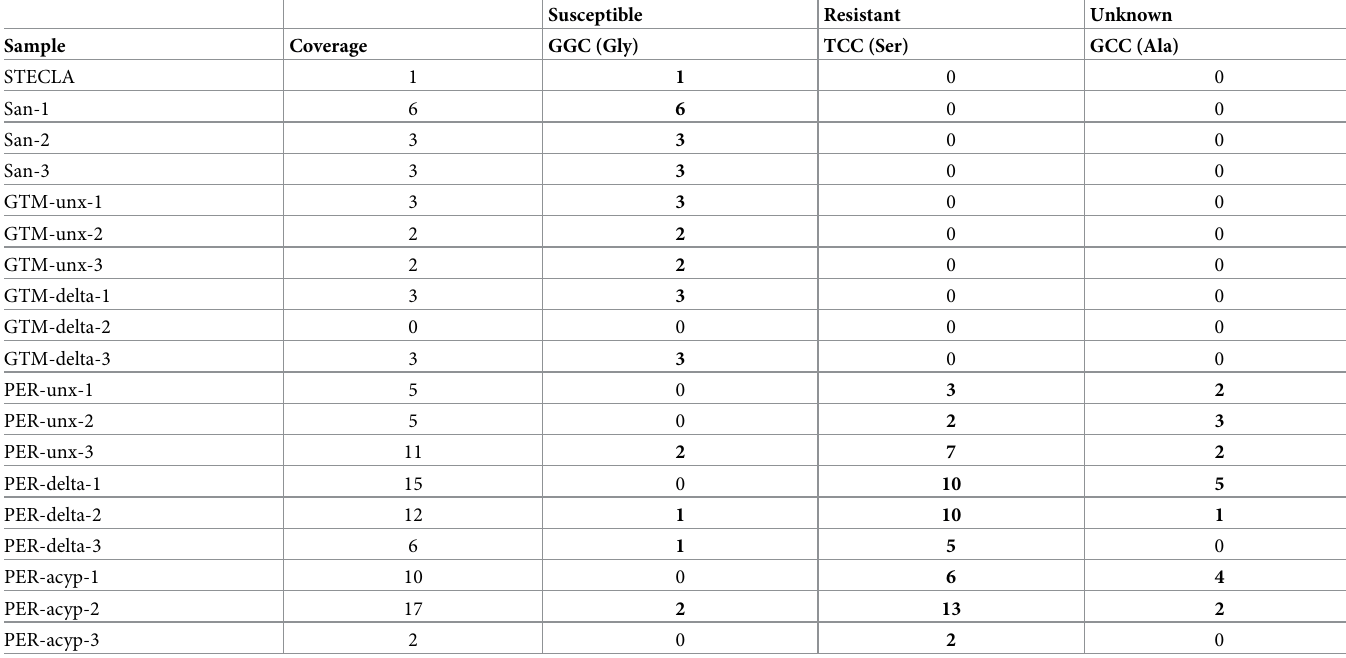
Table 4. Codons present in RNAseq reads at position ‘119’ of the Acetylcholinesterase-1 gene.